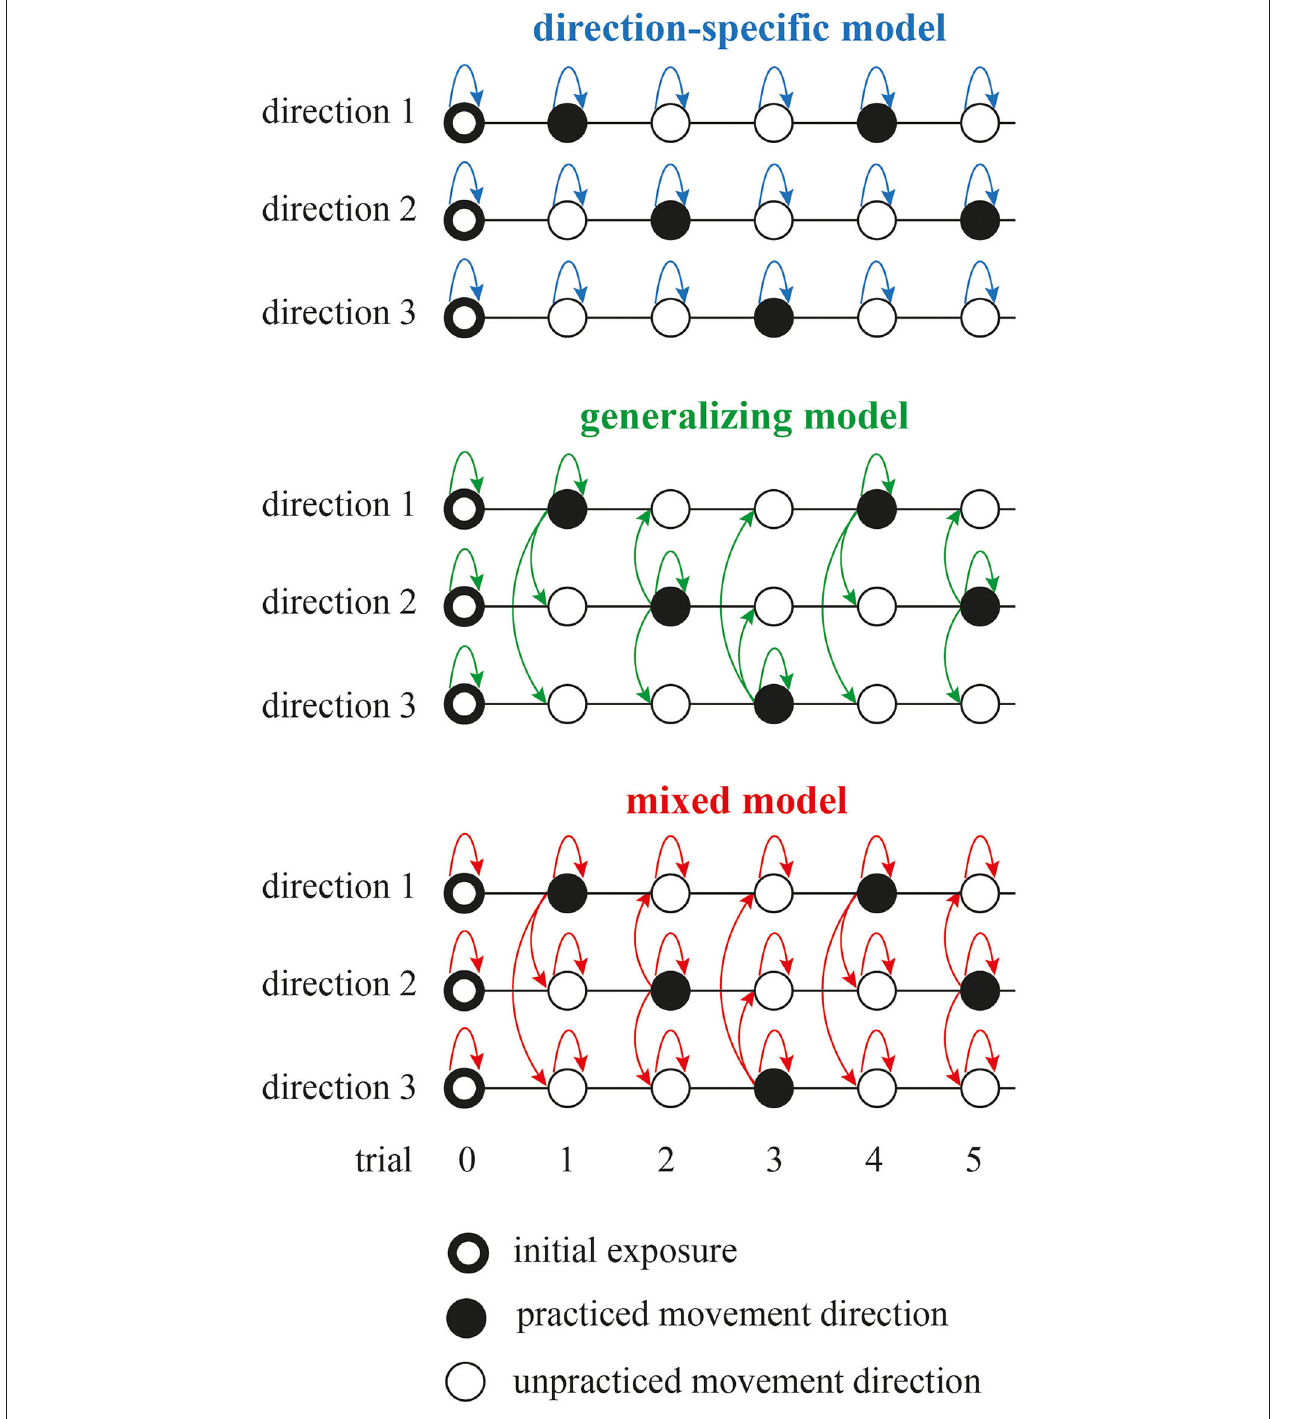
FIGURE 2 | Three model schemes to assess how the initial ballistic launch to the target is shaped by the visually perceived error. The direction-specific model assumes that the learning is independent for each movement direction. The generalizing model assumes that the learning for all movement directions is dependent on the visual error perceived at the practiced movement direction. The mixed model is the weighted sum of previous two models. Dark and white circles depict practiced and unpracticed movement directions, respectively. Ring-shaped markers at trial zero represent initial condition for the models that was based initial exposure to the learning task. Arrows represent update to the model state based on the model structure. Note that the direction-specific model allowed for updates to the model state during the trial gaps between the practiced trials using momentum method. Also note that only three movement directions are shown here for brevity, but there were six movement directions in the